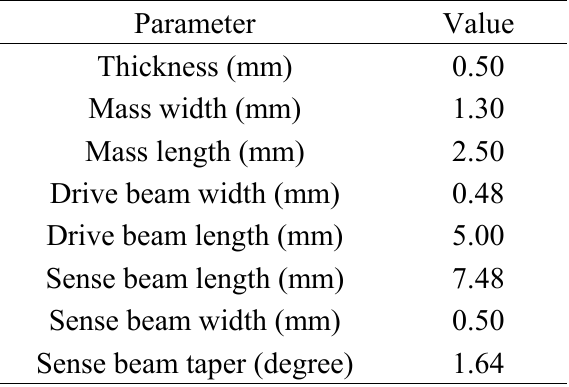
Table 1. Structure parameters of the